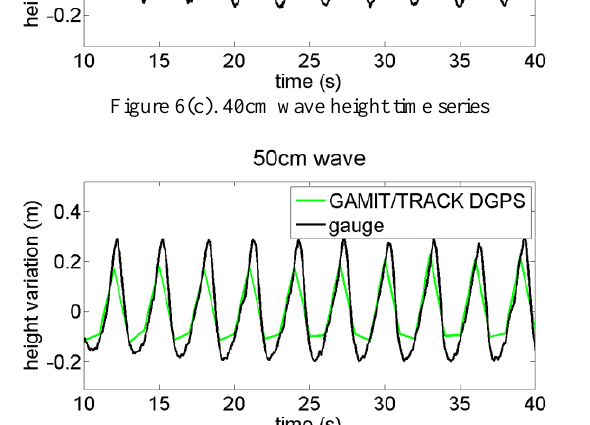
Figure 6(d). 50cm wave height time series